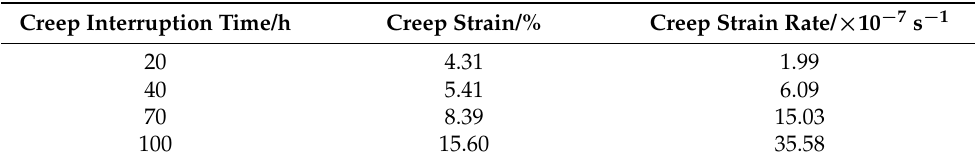
Figure 3. Creep test results under 1050 °C/170 MPa. ( a ) Test piece after rupture, ( b ) time-strain curve, ( c , d ) microstructure after rupture. Table 2. Creep strain and strain rate of samples under different creep interruption